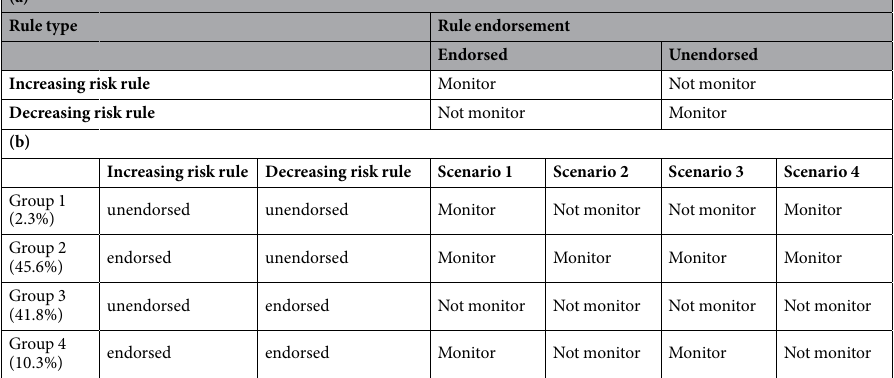
Table 1. ( a ) Individual-rule based monitoring strategies in the next 6 months. ( b ) Multiple-rules based monitoring strategies in the next 6 months. Note: the population is segmented into four groups including un- endorsing any of increasing risk rules and any of decreasing risk rules (Group 1), endorsing any of increasing risk rules but un-endorsing all decreasing risk rules (Group 2), un-endorsing all increasing risk rules but endorsing any of decreasing risk rules (Group 3), and endorsing all rules (Group 4) (percentage of patients in each group is presented in brackets). Four monitoring scenarios are considered: monitoring groups 1, 2 and 4 (Scenario